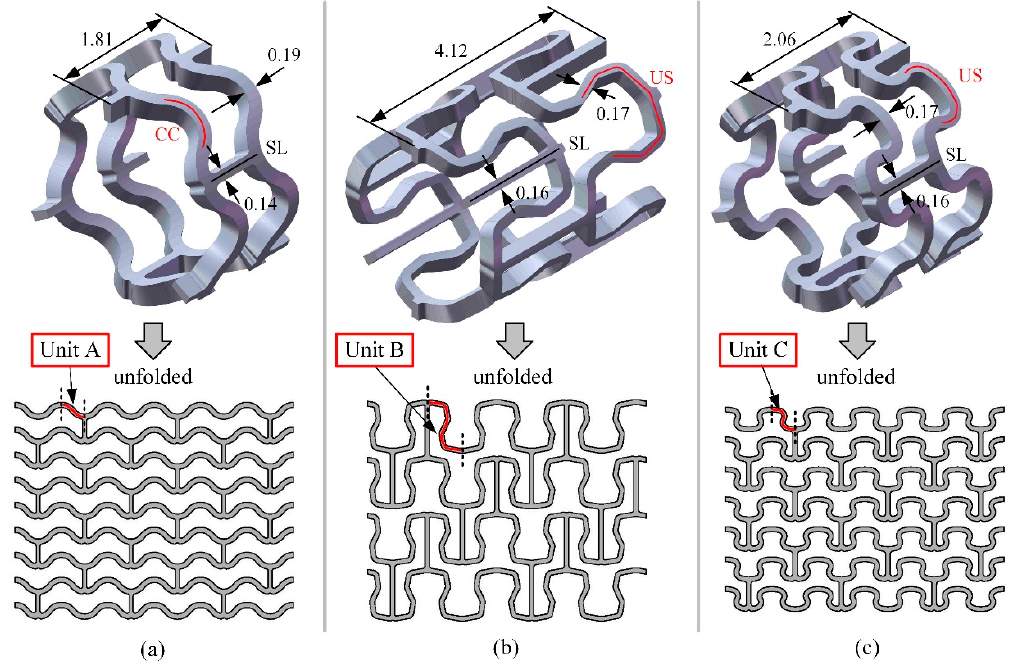
Figure 1. Tubular and planar stents with ( a ) Pattern A, ( b ) Pattern B, and ( c ) Pattern C. All dimensions are in mm.